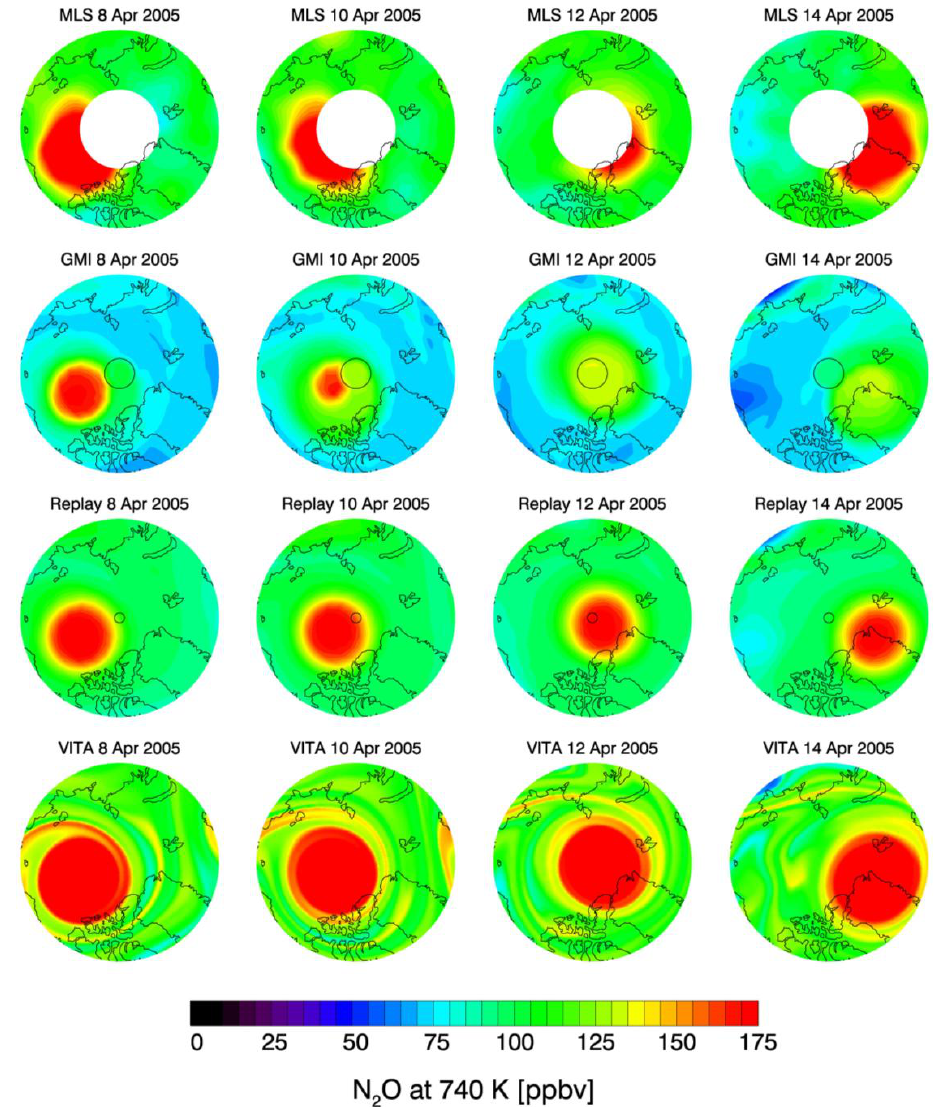
Fig. 10. MLS N 2 O mixing ratio from 70–90 ◦ N at 740K potential temperature for 8, 10, 12, and 14 April 2005 along with simulations from Figure 10. MLS N O mixing ratio from 70–90°N at 740 K potential temperature for 8, 10, 2 2 GMI, Replay, and VITA. Red (blue) indicates high (low) N 2 O values. Black circles indicate the extent of the polar mixing cap in the GMI and Replay 12, and 14 April 2005 along with simulations from GMI, Replay, and VITA. Red (blue) 3 indicates high (low) N O values. Black circles indicate the extent of the polar mixing cap in 4 2 the GMI and Replay simulations. 5